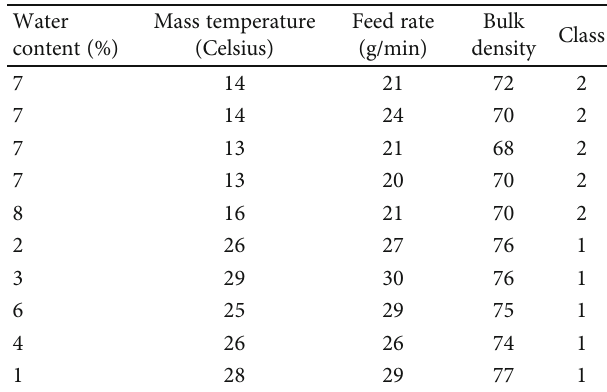
Table 2: The subset of the bread dataset after dimension